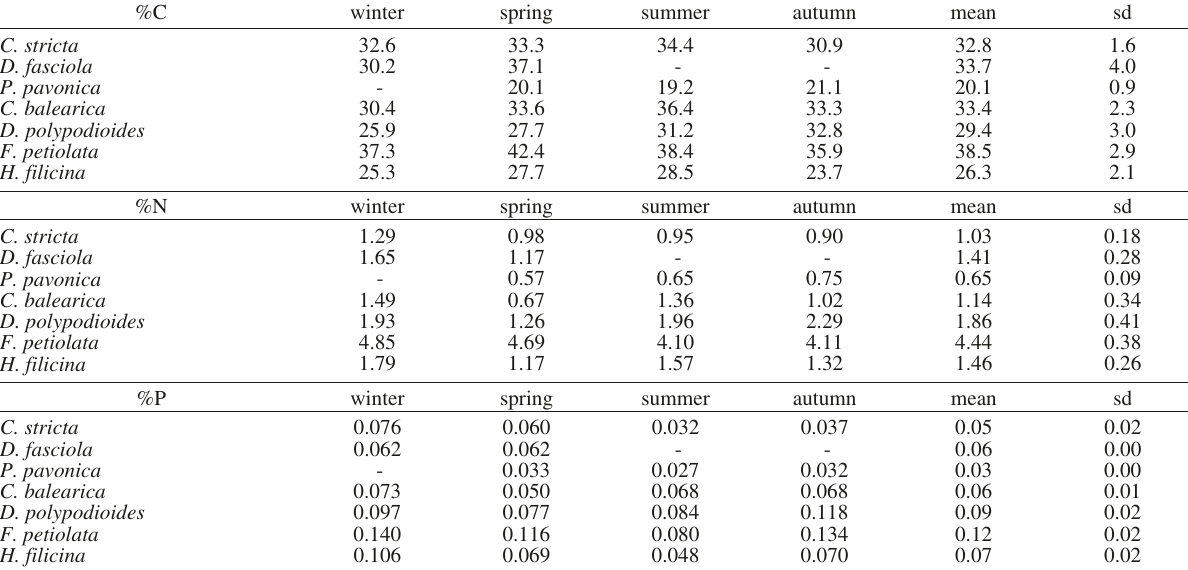
Fig. 6. – C:N, C:P and N:P ratios in tissues for each species and season. Abbreviations as in Figure 4. Cs, Carpodesmia stricta ; Df, Dictyota fasciola ; Pp, Padina pavonica ; Cb, Carpodesmia balearica ; Dp, Dictyopteris polypodioides ; Fp, Flabellia petiolata ; Hf, Halopteris filicina . Table 8. – Carbon (%C), nitrogen (%N) and phosphorus (%P) contents in algal tissues: seasonal values and averages (mean±sd).